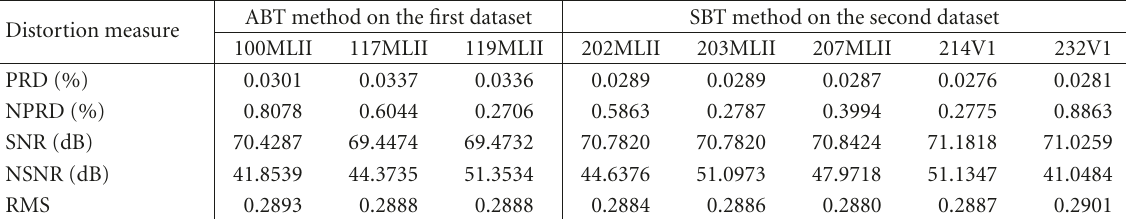
Table 2: Quality performance results using ABT and SBT methods with a fourth-order predictor. Distortion